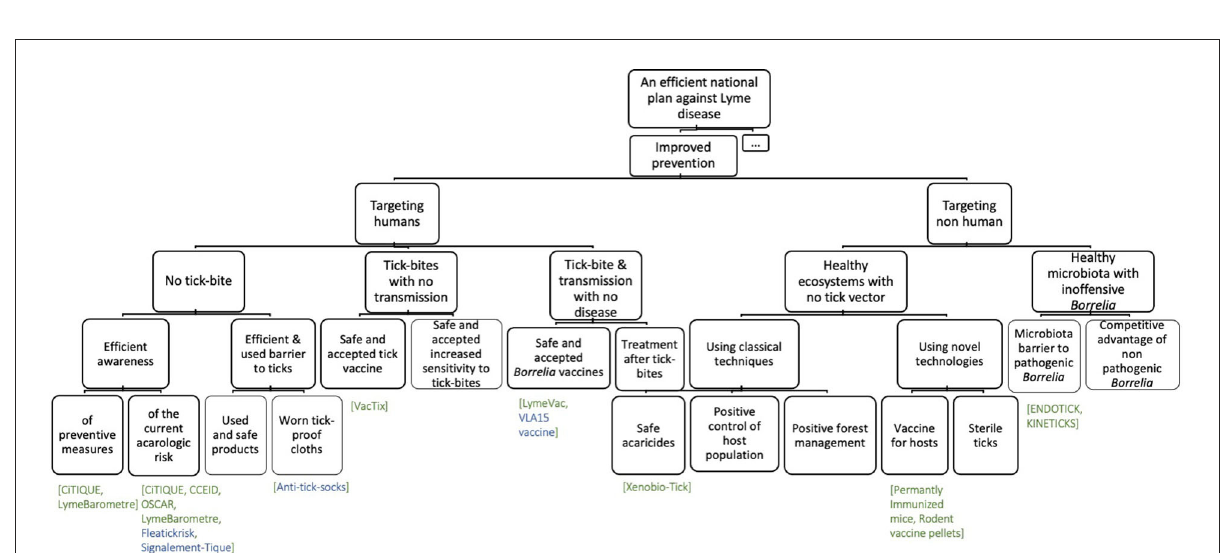
FIGURE5 The concept part of the “improved prevention” partition of the CKf. In green, the names of the identified projects listed in Supp. Mat. 2 In blue, the name of networks or products in development.